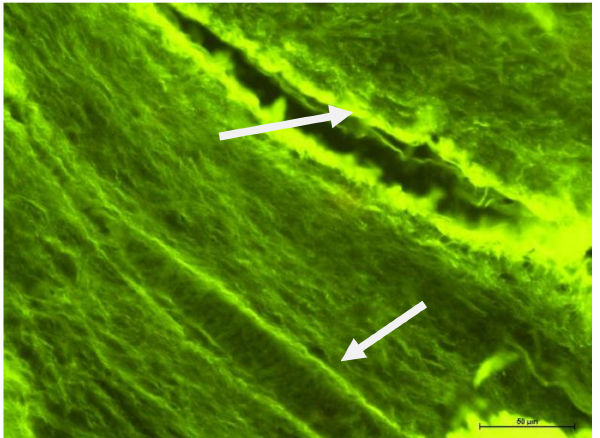
Figure 6. Fluorescence microscope image, human molar—Group II. Visible different types of vessels (arrow) in different sections. UV-2A. Mag. 200 × .